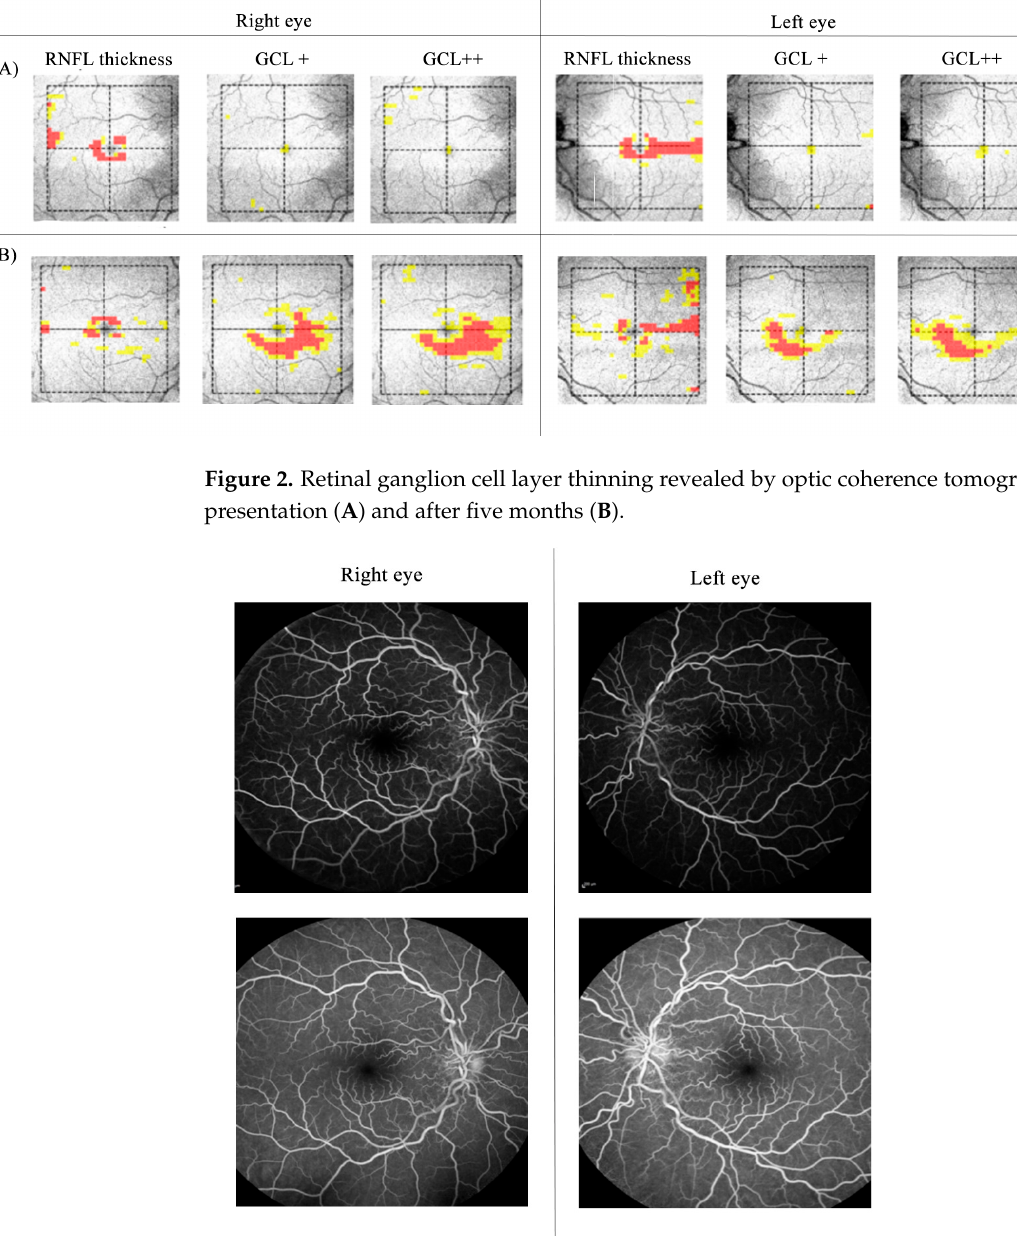
Figure 4. The P100 wave of the visual evoked potentials was diminished before treatment (red ar- rows) and normalized after treatment. A slightly reduced PERG N95 wave in the right eye after five months (orange arrow), showing slight retinal ganglion cell damage in the right eye and normal findings in the left eye.